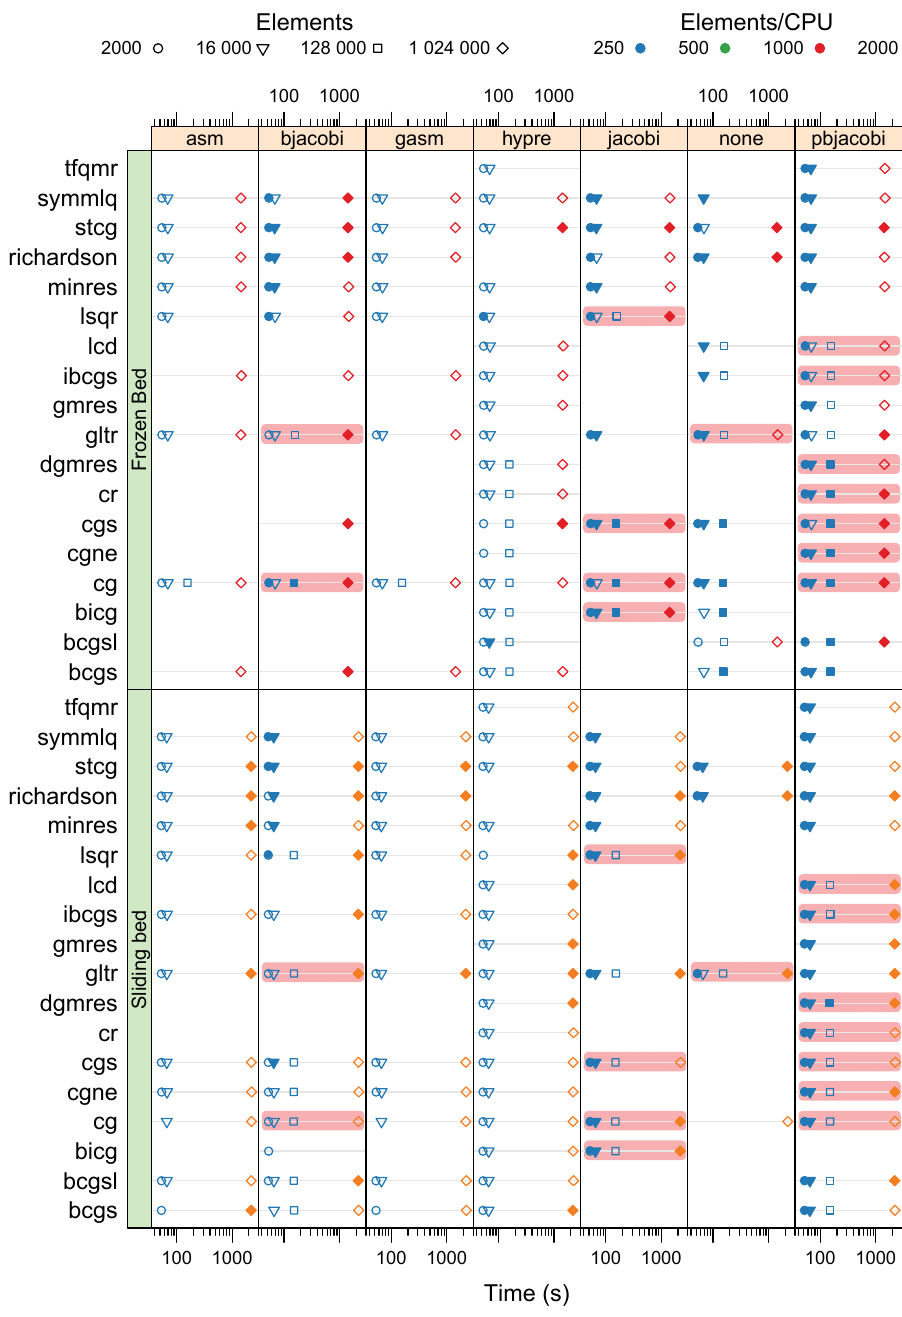
Time (s) Figure 3. Incompressibility analysis: timing results for the fastest solvers (top 5%) tested on ISMIP-HOM Experiment F. The top (1%) timing results are distinguished using color-filled symbols. Red shaded boxes highlight solver combinations that rank among the fastest methods for all model sizes and both bed conditions (i.e., four symbols in the top and bottom frame). See Fig. 2 for more details.